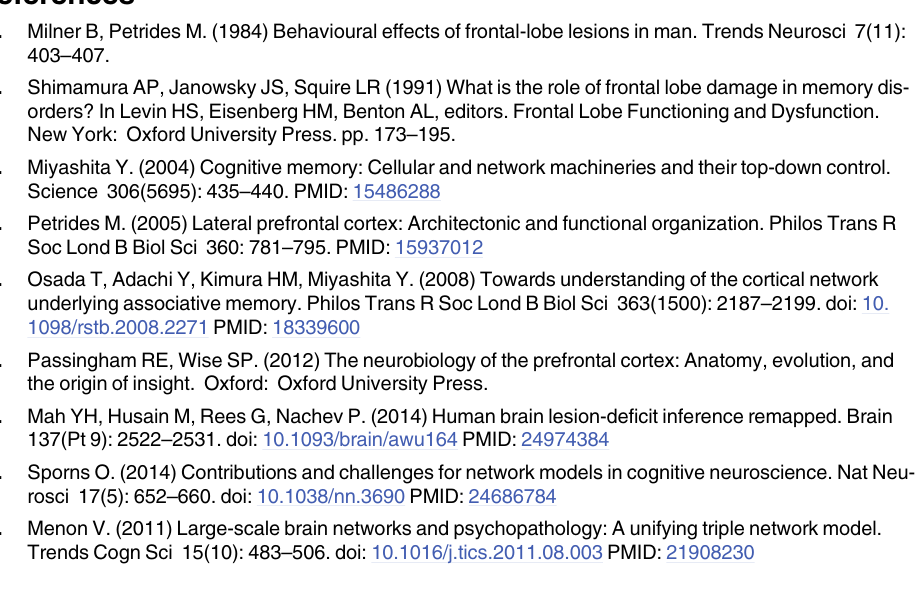
S2 Table. Reaction time-corrected activation in homotopic areas. Significant peaks at a voxel level of p < 0.05 corrected by FDR. Coordinates are listed in monkey bicommissural space [26,28,34]. S3 Table. Activation revealed by the contrast of MIDDLE minus EITHER-END in homoto- pic areas. Significant peaks at a voxel level of p < 0.05 corrected by FWE within group homo- topic regions. Coordinates are listed in monkey bicommissural space [26,28,34]. S4 Table. Activations in homotopic areas in delayed matching-to-sample task. Significant peaks at a voxel level of p < 0.05 corrected by FWE. Coordinates are listed in monkey bicom- missural space [26,28,34]. † Significant only at a voxel level of p <